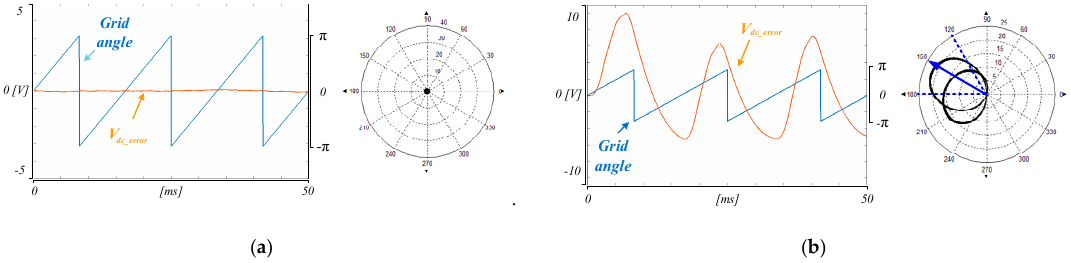
Figure 5. DC-link capacitor voltage and vector trajectory according to open-switch fault of S a 3 . ( a ) Healthy condition; ( b ) Faulty condition.